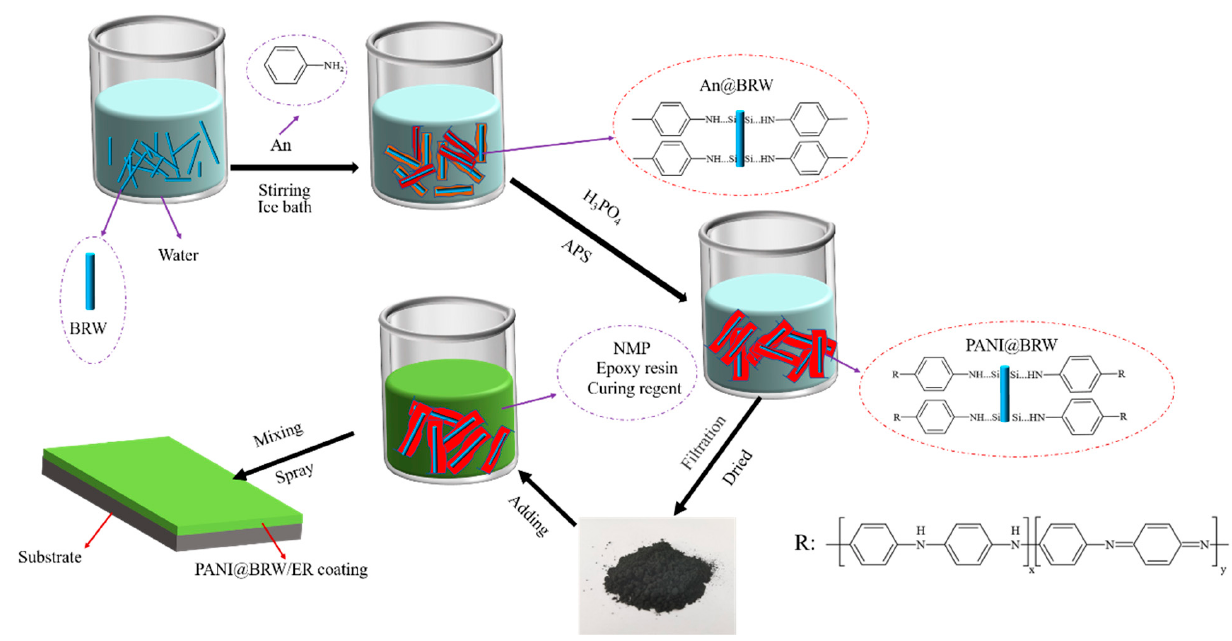
Figure 2. Preparation of polyaniline-coated basalt rockwool wastes/epoxy resin (PANI@BRW/ER) coating.